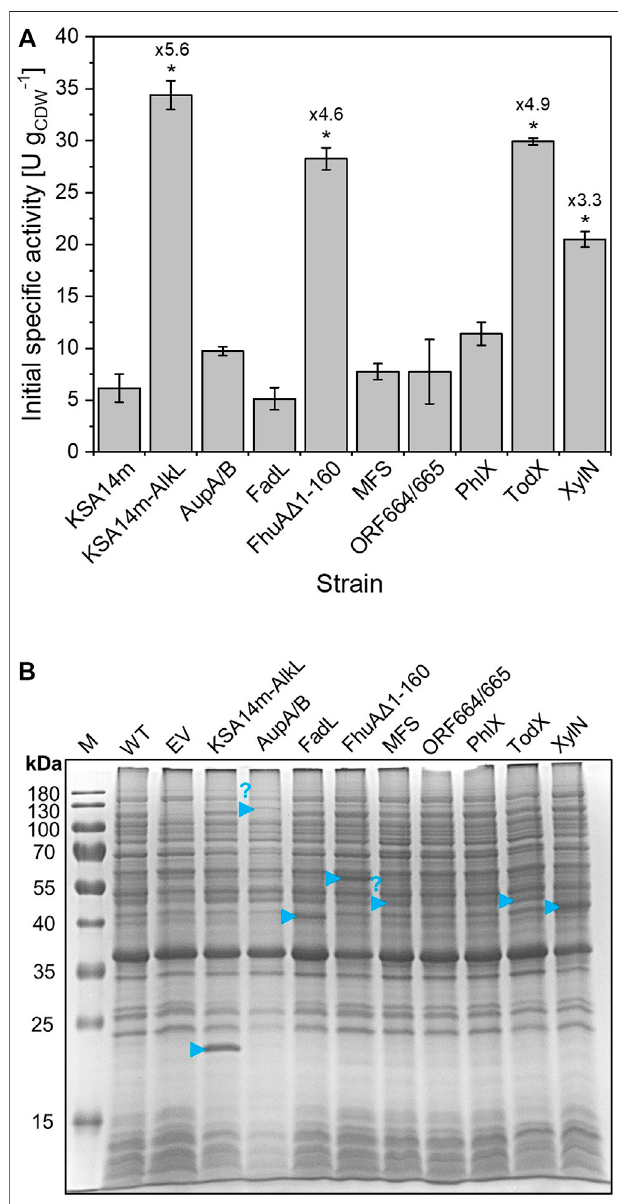
FIGURE 4 | Initial speci fi c testosterone hydroxylation activities (A) of resting E. coli BL21-Gold(DE3) cells carrying pETM11 with ksa14m and the genes encoding different membrane proteins after cultivation in M9 medium supplemented with 0.5% (w/v) glucose. Resting cell preparation and activity assays were conducted as described in the Materials and Methods section. Average values and standard deviations of two biological replicates are given. Statistical analysis was performed using Student ’ s t test, and the values were taken as signi fi cantly different when p ≤ 0.05. (B) SDS-PAGE analysis of total membrane fractions isolated from the respective bacterial strains 5 h after induction with 0.1 mM IPTG and addition of 0.5 mM 5- aminolevulinic acid. Blue arrows point to the protein bands at the sizes expected for the respective membrane proteins.